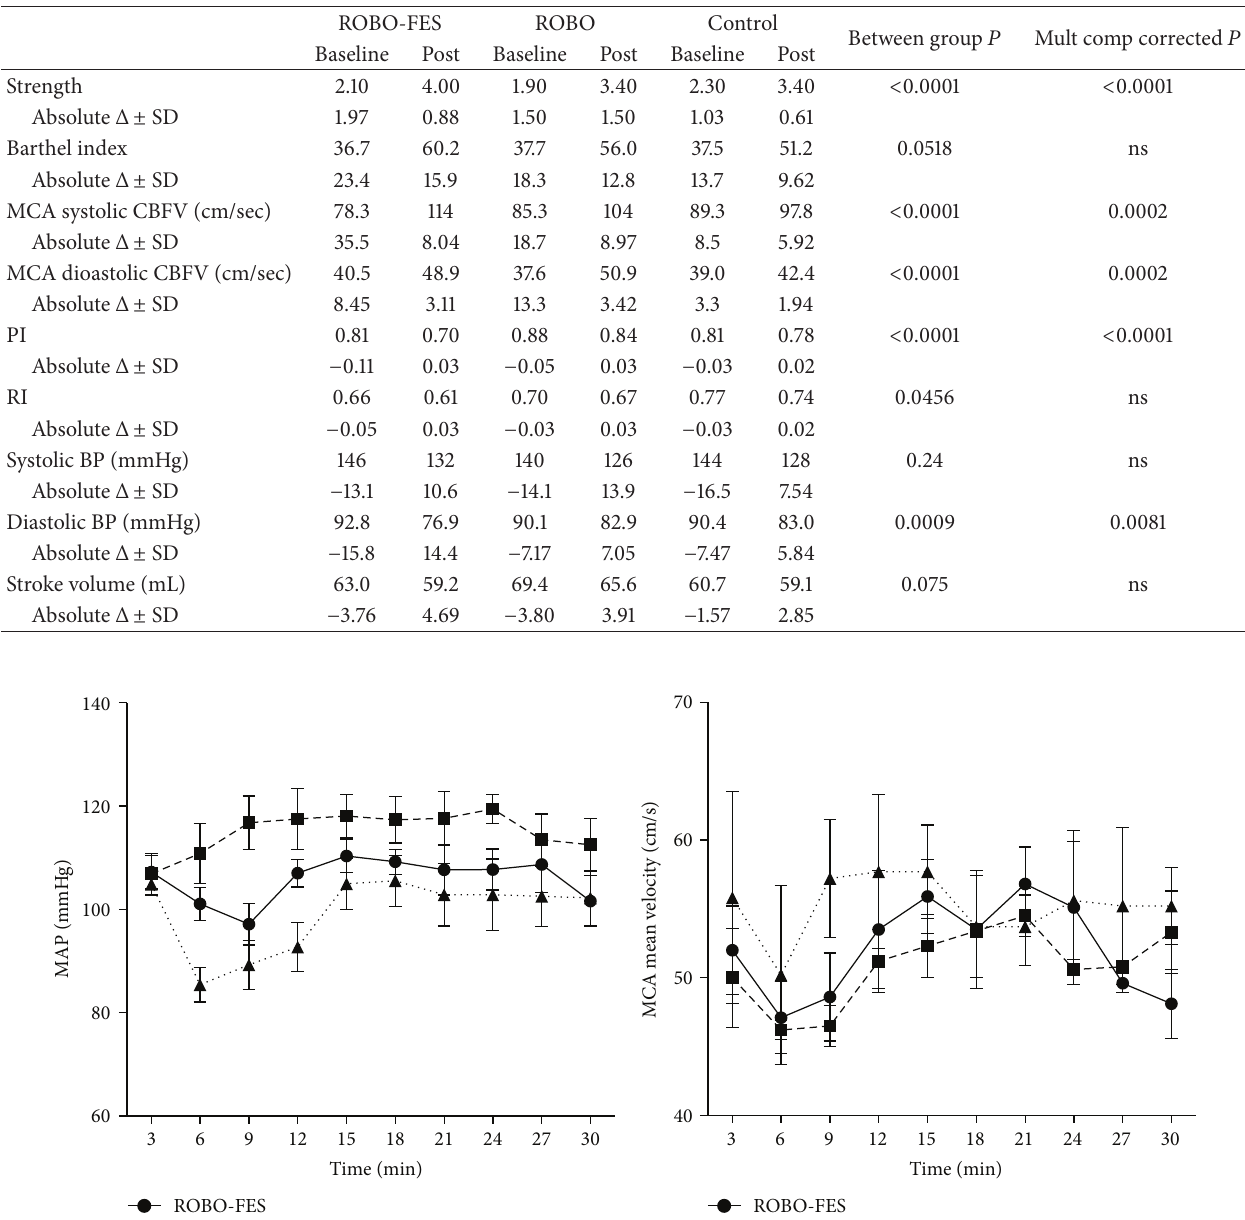
Table 2: Change in outcome measure within each group. ROBO-FES ROBO Control